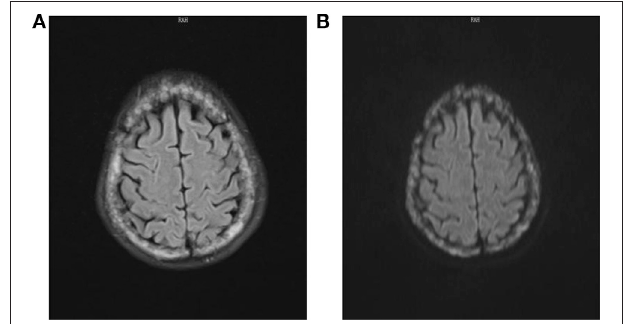
FIGURE 1 | FLAIR (A) and DWI (B) sequences of cranial MRI showed diffuse thickening of the skull and increasing signal intensity.